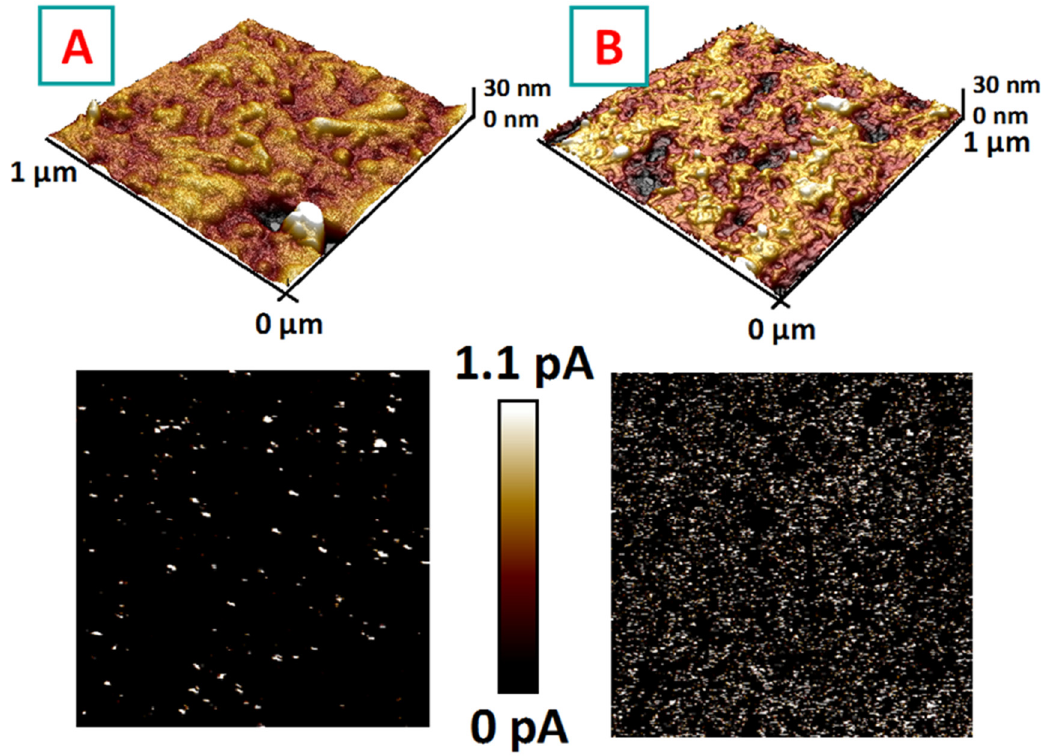
Figure 4. AFM morphology and conductivity scans measured on screened ( A ) and illuminated ( B ) areas of patterned PEDOT:PSS-NAP thin film.